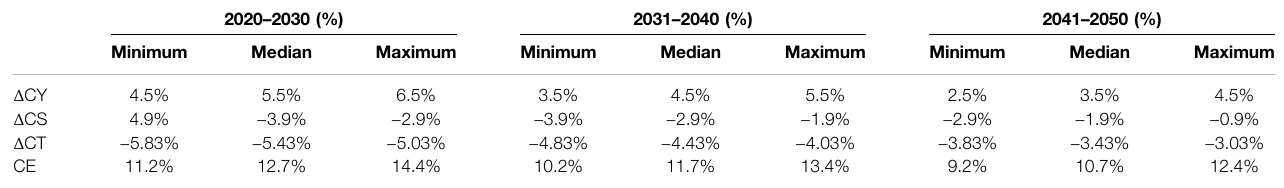
TABLE 10 | Potential change rate of each in fl uencing factor under the technological breakthrough